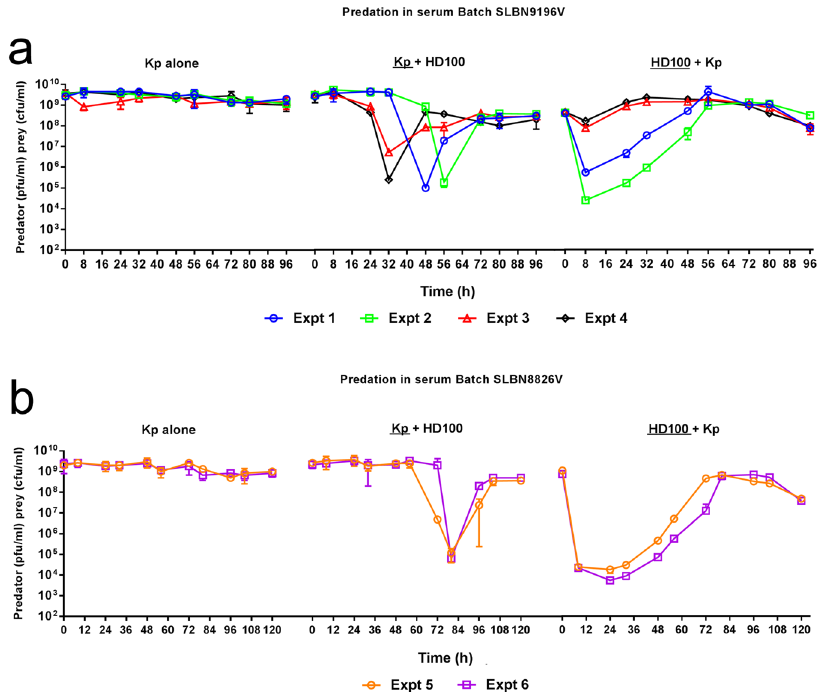
Figure 5. Predation in two different batches of whole human serum. (a) Serum batch SLBN9196V. (b) Serum batch SLBN8826V. Graphs show individual biological repeats of the live bacterial counts from predation in serum experiments, results from each individual biological experiment (Expt) are represented by the same colour line on each graph. Changes in the population of both K. pneumoniae prey (Kp + HD100) and B. bacteriovorus HD100 predator (HD100 + Kp) were enumerated periodically during the predation assay. As a control, prey suspended in serum was enumerated periodically in the absence of B. bacteriovorus HD100 predator (Kp alone). Despite illustrating some differences, similar patterns were seen across all 6 experimental